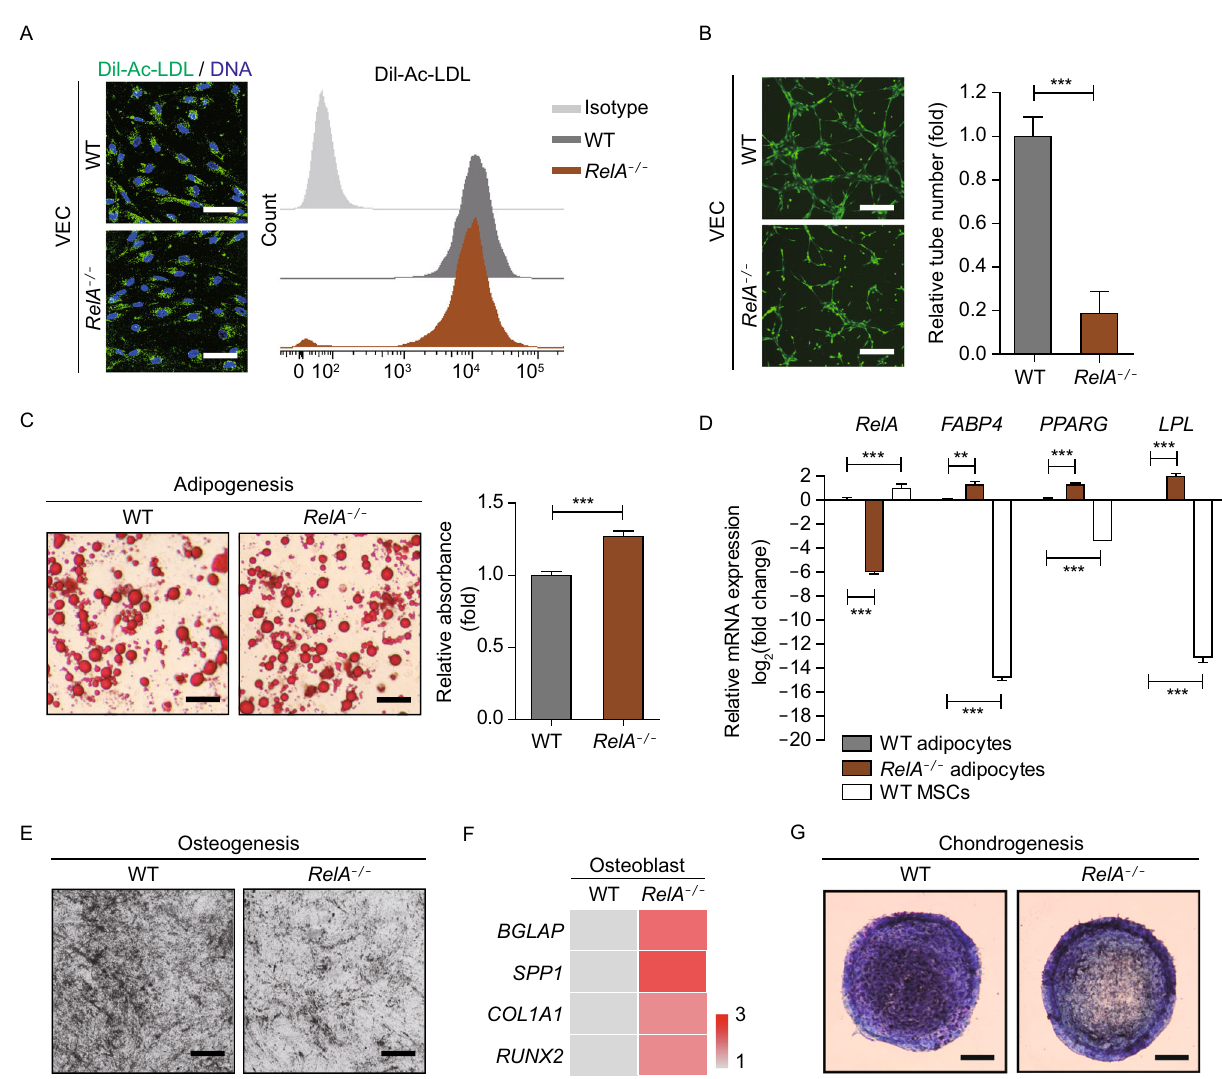
Figure 3. RelA de fi ciency affected vascular cell homeostasis. (A) Immunostaining and fl ow cytometry analysis of the Dil-Ac-LDL uptake capacity in WTand RelA − / − VECs. DNA was labeled by Hoechst 33342. Scale bar, 30 μ m. (B) Representative micrographs of matrigel tubes formed by WTand RelA − / − VECs in vitro ( n = 3). Scale bar, 3 mm. (C) Oil red O staining of WTand RelA − / − adipocytes derived from MSCs, respectively. The quanti fi cation of adipocytes was measured by absorbance at 510 nm ( n = 4). *** P < 0.001. Scale bar, 3 mm. (D) Transcriptional expression of adipocyte-speci fi c genes in WT and RelA − / − adipocytes via RT-qPCR detection ( n = 4). WT MSCs were used as a negative control. 18S was used as a loading control. * P < 0.05. ** P < 0.01. *** P < 0.001. (E) Representative micrographs of WTand RelA − / − osteoblasts by Von Kossa staining. Scale bar, 3 mm. (F) Transcriptional levels of osteoblast-speci fi c gene expression in WTand RelA − / − osteoblasts via RT-qPCR detection ( n = 4). 18S was used as a loading control. (G) Representative toluidine blue staining images of WT and RelA − / − chondrocytes. Scale bar, 3